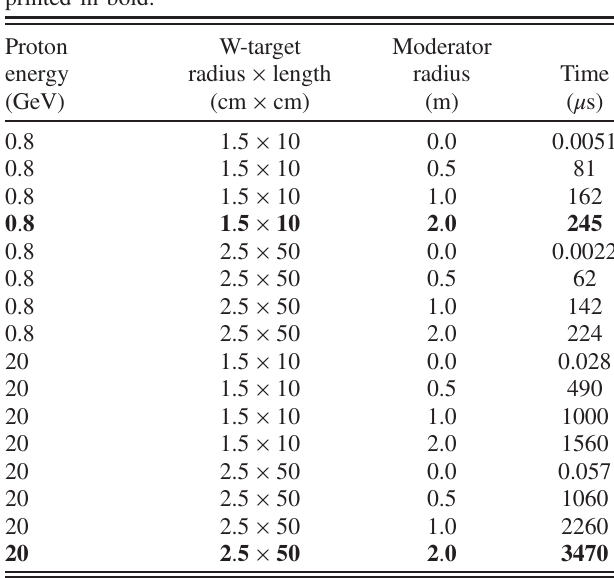
TABLE II. Average total time period neutrons spend inside the ion beam pipe per proton [ ¯ t , see Eq. (1)]. The recom- neutron ; tot mended settings for a beam energy of 800 MeV and 20 GeV are printed in bold.